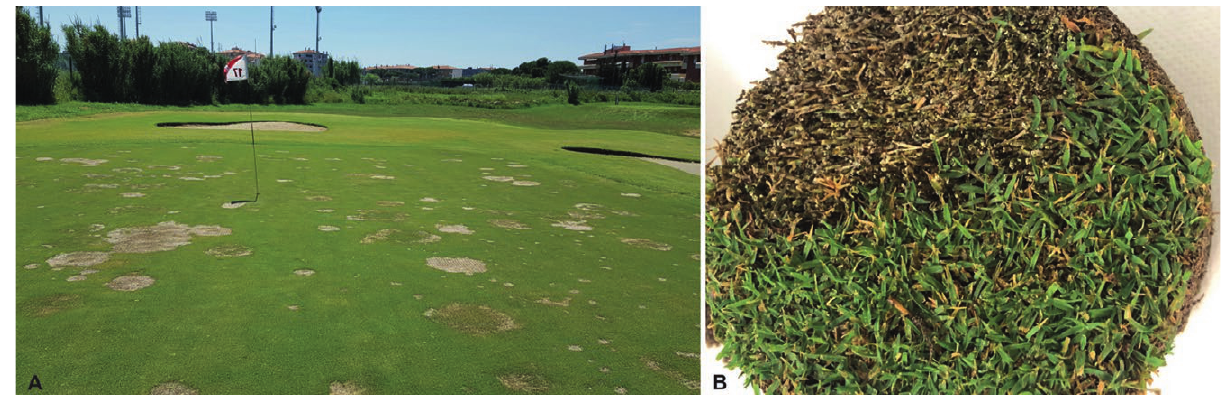
Figure 1. Necrotic areas caused by Curvularia americana and C. tropicalis observed on a golf course green (A), and affected leaves